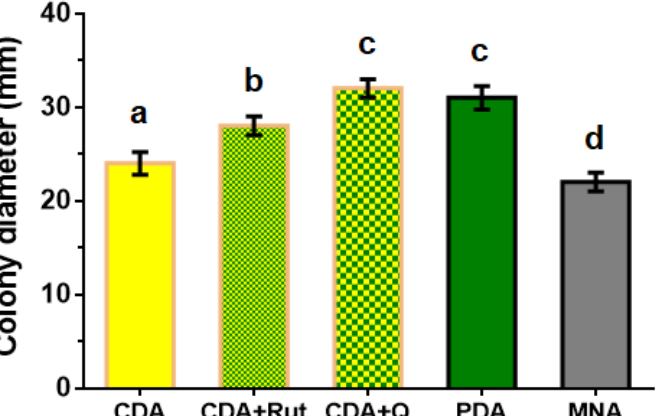
nutrient media. CDA—Czapek–Dox agar medium, CDA+Rut—Czapek–Dox agar medium Figure 3. Diameter of 14-day colonies of P. fortinii DSE2 isolate developed on different types of nutrient media. CDA — Czapek – Dox agar medium, CDA+Rut — Czapek – Dox agar medium with the addition of rutin to final concentration of 10 μM, CDA+Q— Czapek – Dox agar medium with the